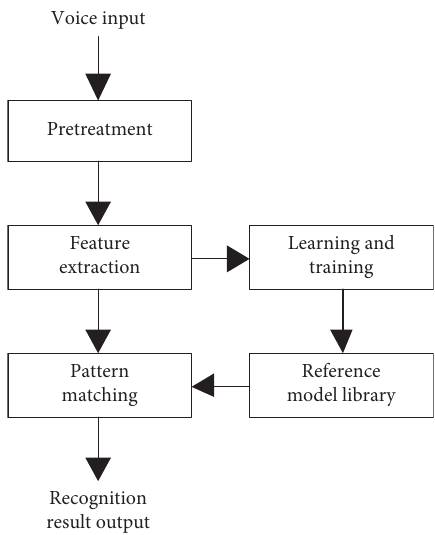
Figure 6: Speech recognition process.